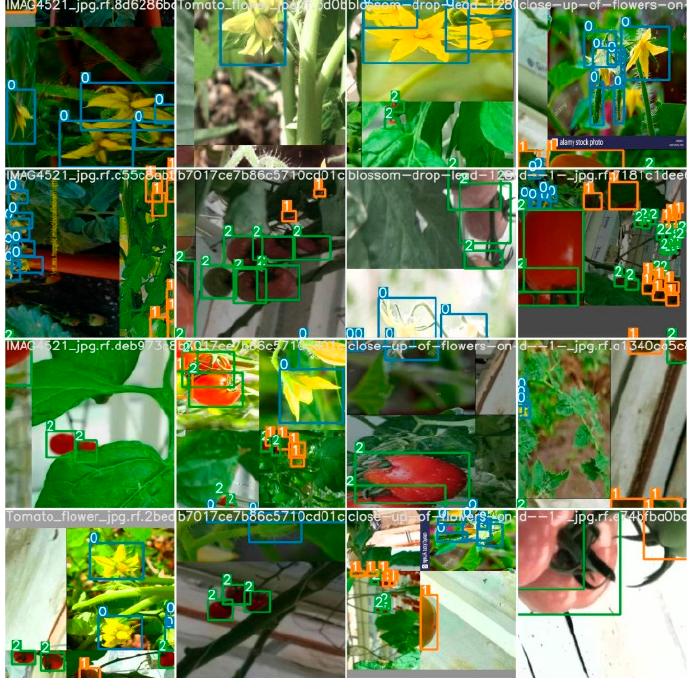
Figure 10. Obtained training results batch for Tomato detection model. Here, 0, 1, and 2 labels represent flower, green tomato, and red tomato classes, respectively